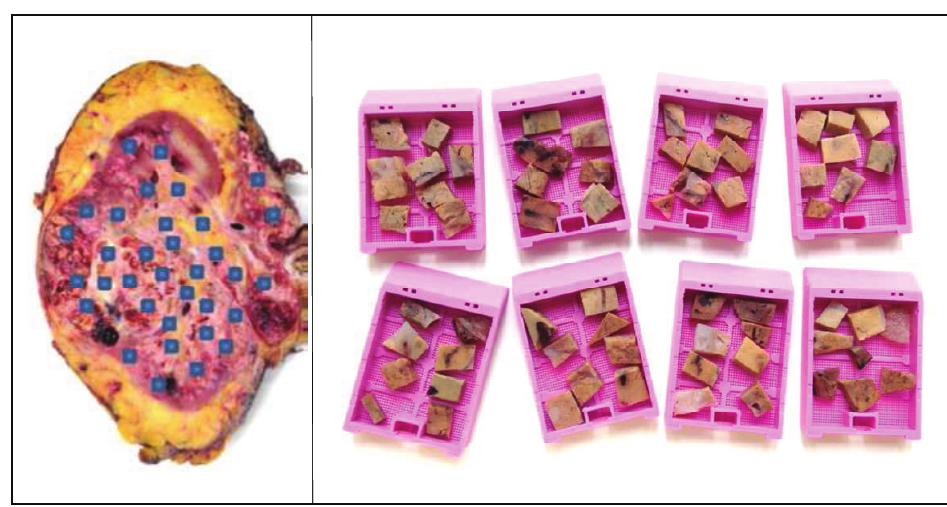
Figure 1. Example of multi-site tumor sampling (MSTS) following the divide and conquer (DAC)